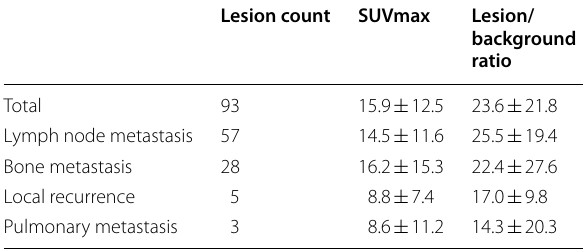
Table 1 Lesions detected in early-phase PET/CT Lesion count SUVmax Lesion/ background